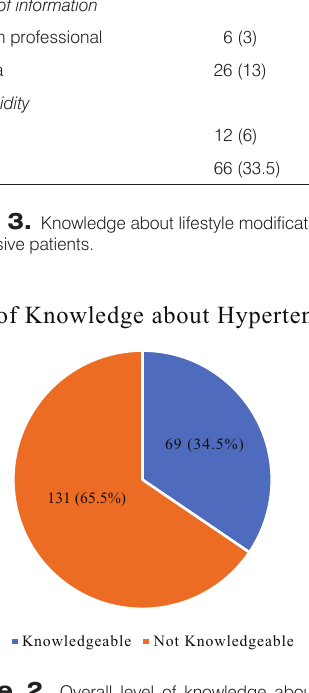
Figure 2. Overall level of knowledge about lifestyle modification practice and level of knowledge about hypertension and associated factors among hypertensive